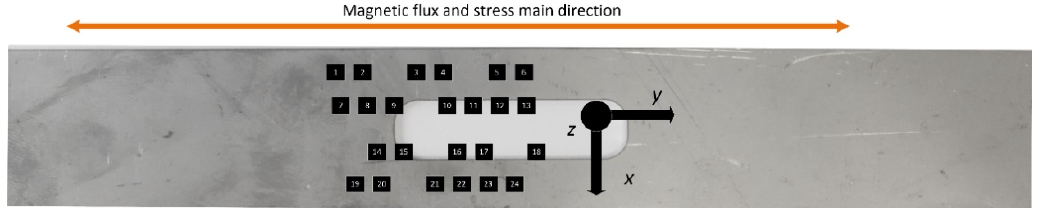
Figure 5. Arrangement of the magnetic field sensors of the matrix relative to the tested sample.